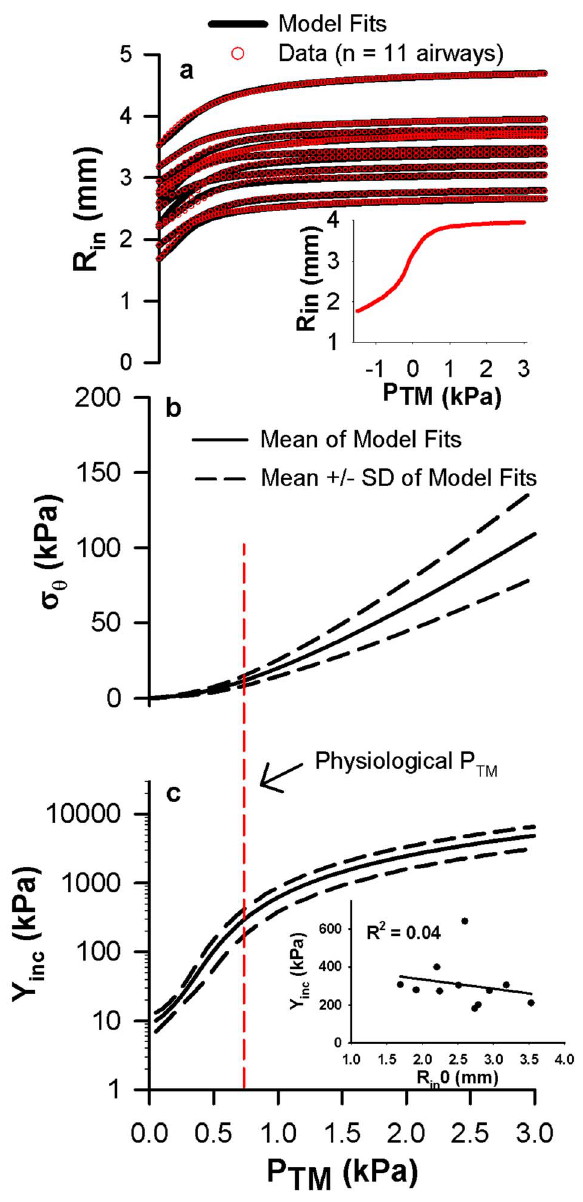
Figure 1. The existence of governing mechanical relationships in bovine intact airways. a , Relationships between luminal radius (R in ) and transmural pressure (P TM ) in 11 bovine airways. Red open circles are the measured data and black lines are the regression fits. The inset shows a representative example of a full R in vs P TM curve, from which we only utilize the positive pressures. b , Relationships between circumferential stress ( s h ) evaluated at the inner surface of the wall and P TM calculated from the R in -P TM regression analysis. c , Relationships between incremental elastic modulus (Y inc ) and P TM calculated from Eq. 6. In panels b and c, the black solid lines represent the mean of all 11 airways and the black dashed lines represent the mean + / 2 standard deviation. The red dashed line represents the typical operating P TM experienced by airways. Note that the spread in s h about the mean is small at the physiological P TM of 0.75 kPa. The inset shows no correlation between Y inc at 0.75 kPa P TM and absolute airway size.